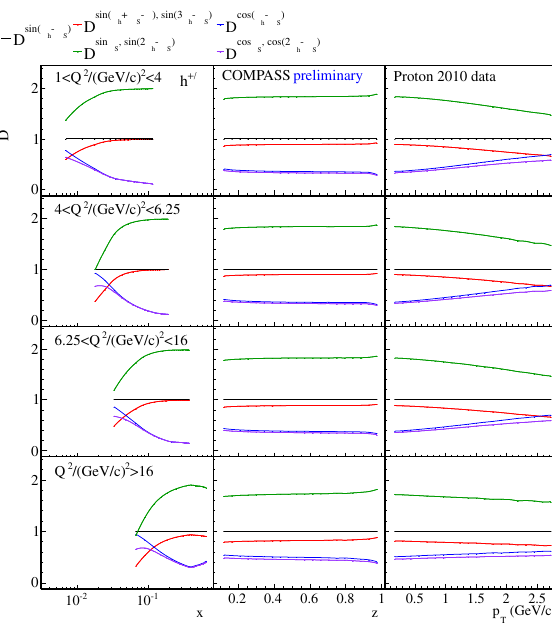
Figure 2. COMPASS x: Q 2 phase-space with indicated four Drell-Yan Q 2 -ranges (top). COMPASS multidimensional kinematical "map" (bottom). Figure 3. Mean depolarization